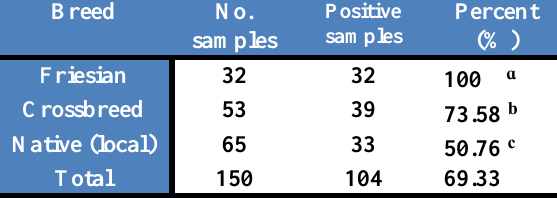
Table, 3: Percentage of positive LSD samples according to cattle breeds by PCR.